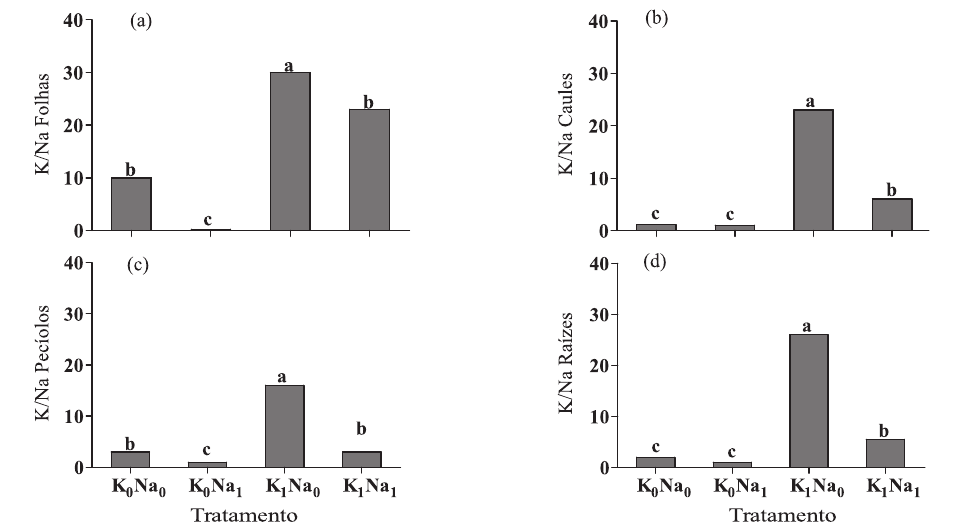
figura 4. Dados da relação K/na em (a) folhas, (b) caule, (c) pecíolos e (d) raízes de plantas de pinhão- manso submetidas a diferentes concentrações externas de K e na por um período de oito dias. K 0 : ausência de potássio; K 1 : 10 mmol l -1 de K; na 0 : ausência de sódio; e na 1 : 50 mmol l -1 de na na solução nutritiva. os valores representam médias de cinco repetições. médias iguais seguidas de letras minúsculas não denotam diferenças significativas, conforme o teste de Tukey (p <